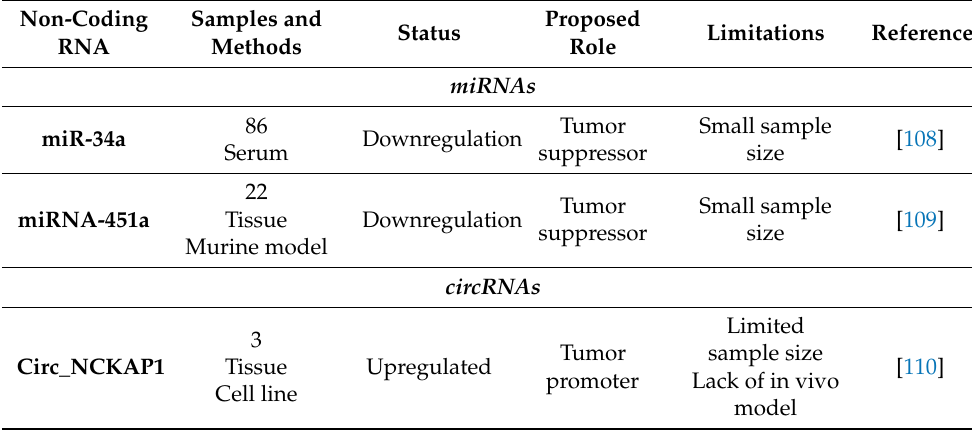
Table 3. Non-coding RNAs implicated in